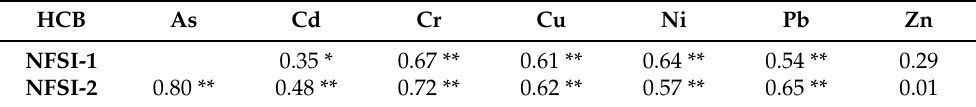
Table 6. Correlation coefficients between HCB concentration and the As, Cd, Cr, Cu, Ni, Pb and Zn concentrations in the humus layers of Brandenburg NFSI sites differentiated for data from NFSI-1 (n = 36) and NFSI-2 (n = 50); significance: * p < 0.05, ** p < 0.01.